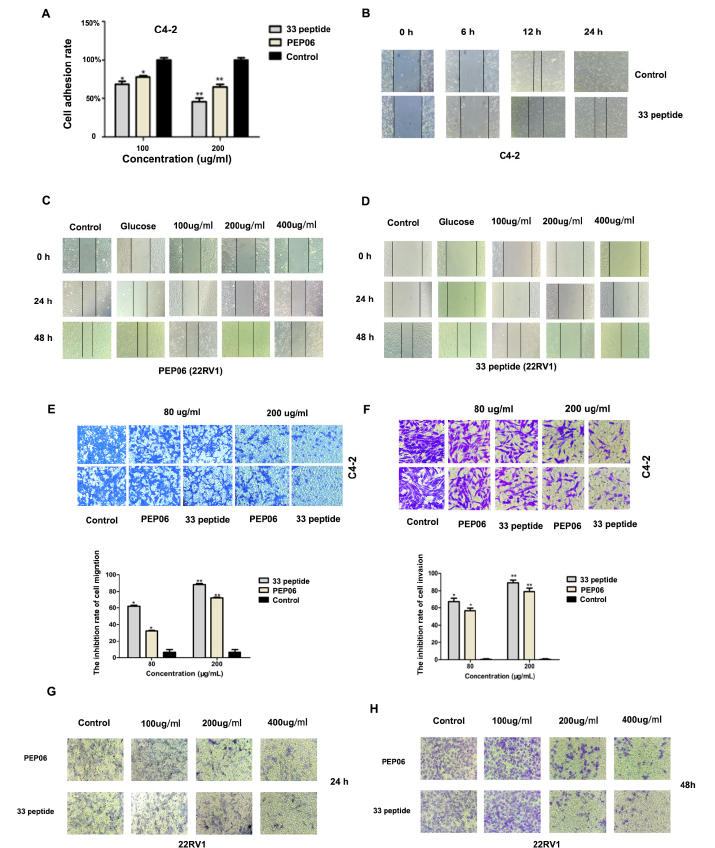
Figure 3. ( A ): C4-2 cell adhesion capacity was measured by cell Matrigel assay in the 33 polypeptide (100 or 200 µ g/mL) treatment group, the PEP06 (100 or 200 µ g/mL) treatment group and the 5% glucose saline treatment group. ( B ): Wound healing assay was performed to detect C4-2 cell migration in the 33 polypeptide (200 µ g/mL) group and 5% glucose saline group after 0 h, 6 h, 12 h and 48 h treatment. ( C ): Wound healing assay was performed to detect the migration of 22RV1 cells in PEP06 group (100 µ g/mL, 200 µ g/mL and 400 µ g/mL), 5% glucose saline group and control group after 0 h, 24 h and 48 h, respectively. ( D ): Wound healing assay was performed to detect the migration of 22RV1 cells in the 33 polypeptide group (100 µ g/mL, 200 µ g/mL and 400 µ g/mL), 5% glucose saline group and control group after 0 h, 24 h and 48 h treatment, respectively. ( E , F ): Transwell assay was used to detect the migration or invasion ability of C4-2 cells in the 33 polypeptide group (80 µ g/mL and 200 µ g/mL), PEP06 group (80 µ g/mL and 200 µ g/mL) and 5% glucose saline group. ( G , H ): Transwell assay was performed to detect the migration of 22RV1 cells of the 33 polypeptide (100 µ g/mL, 200 µ g/mL and 400 µ g/mL) group, PEP06 (100 µ g/mL, 200 µ g/mL and 400 µ g/mL) group and control group for 24 h or 48 h. (* and ** stand for p value < 0.05 and 0.01,